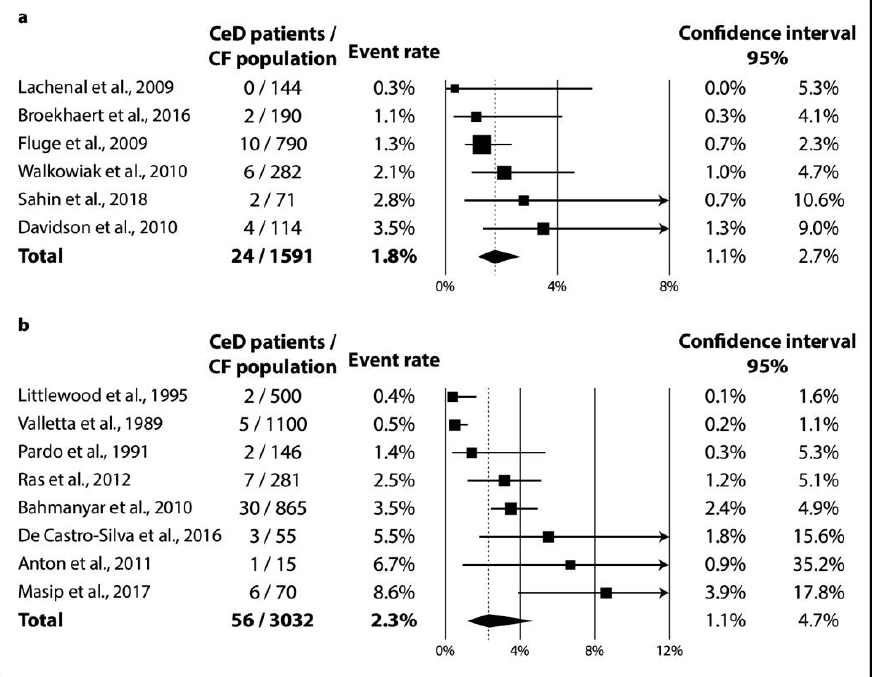
Figure 3. Prevalence of biopsy-verified CeD: ( a ) CeD prevalence from consecutive studies; ( b ) CeD prevalence from non-consecutive studies (CeD: celiac disease, CF: cystic fibrosis).